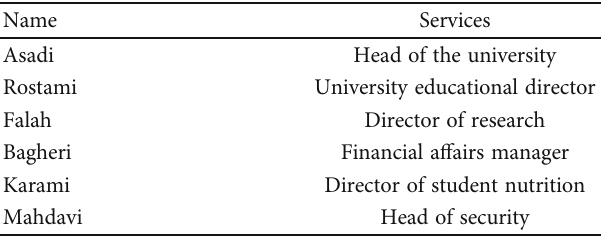
Figure 5: Vague incidence graph G with strong pairs. Table 2: Name of employees in an university and their services.